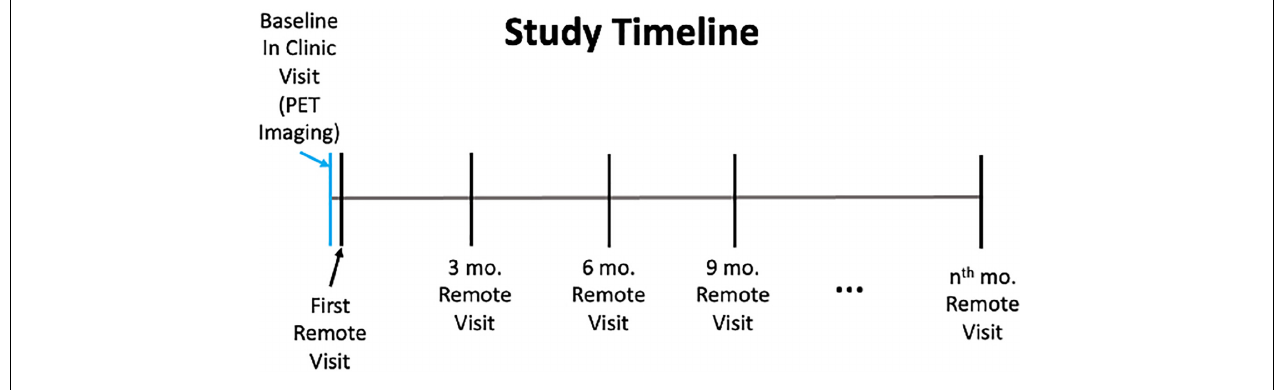
FIGURE 1 | Study timeline.